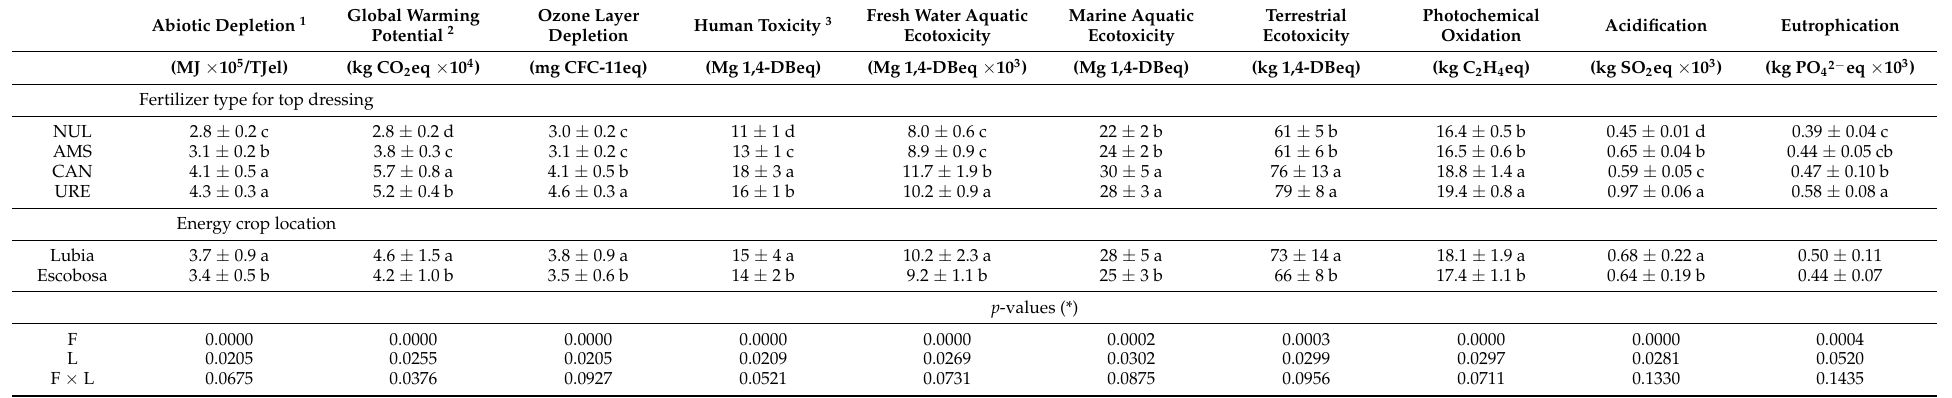
Table 8. Impact categories (means ± standard deviations) depending on the N fertilizer type used for top dressing and